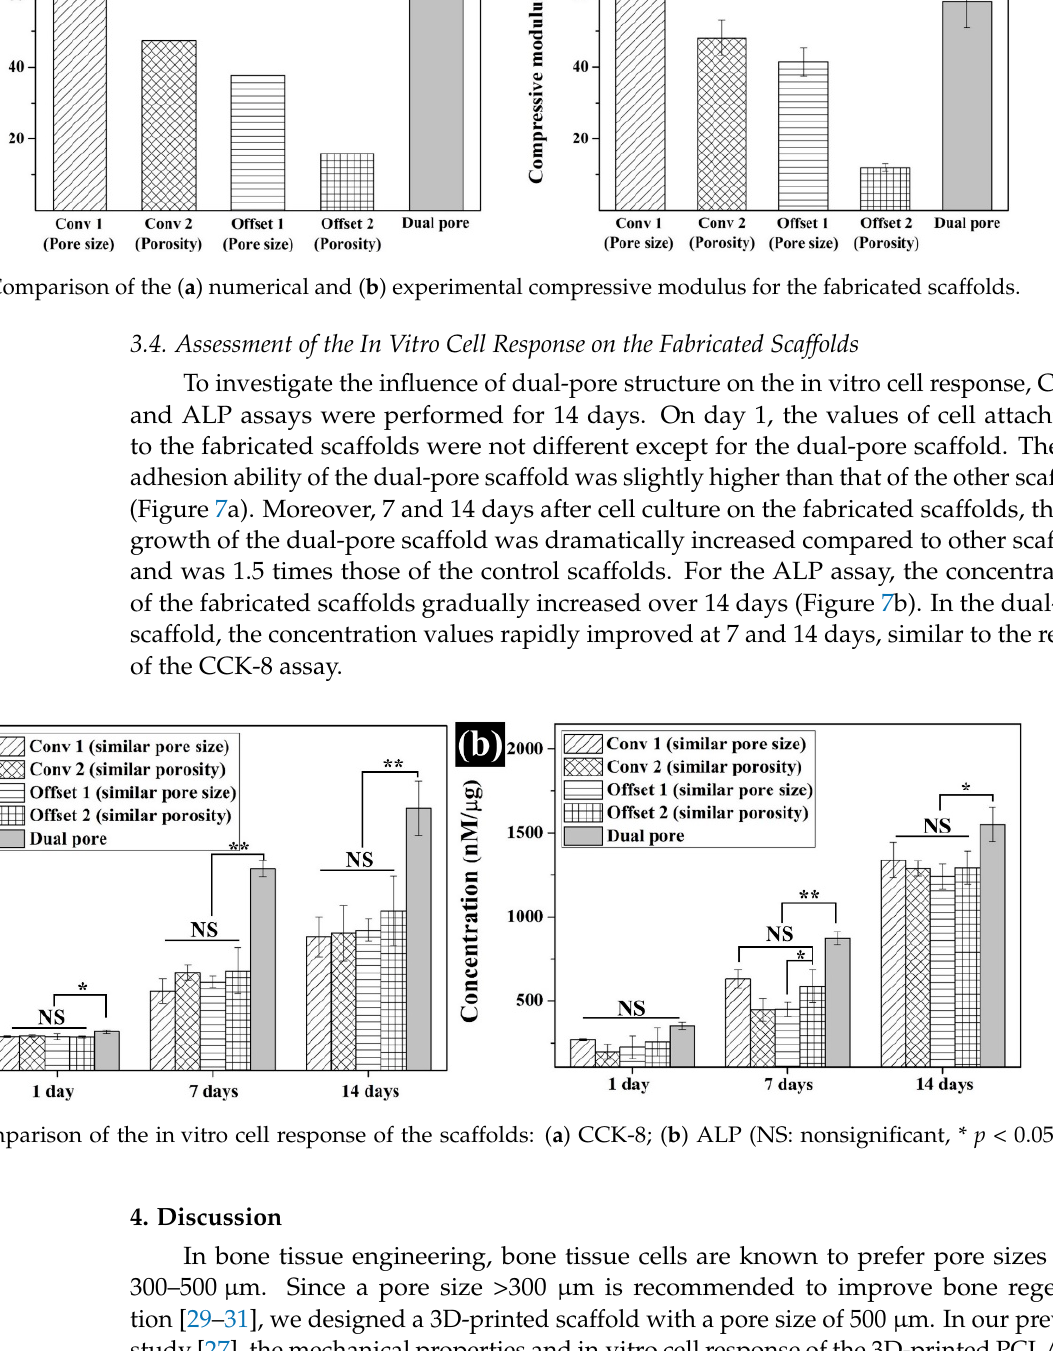
Figure 5. Deformed configuration and von Mises stress of the fabricated scaffold: ( a ) and ( b ) are the cross-sectional position of the designed scaffolds for the stress plot; ( c – g ) are the deformed configuration and von Mises stress of the designed scaffolds.